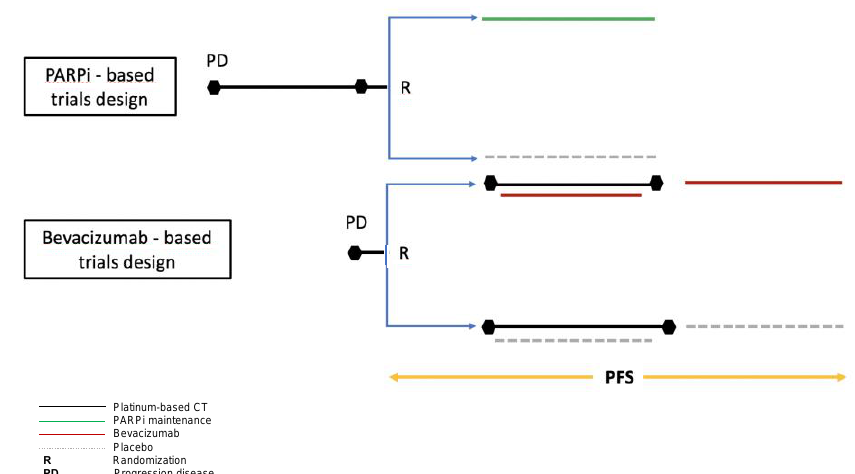
Figure 3. Different designs between PARPi and bevacizumab pivotal trials. In the bevacizumab-based trial randomization was performed at disease progression, before chemotherapy started; In the PARPi-based trials randomization occurred in the case of partial or complete response to platinum therapy.